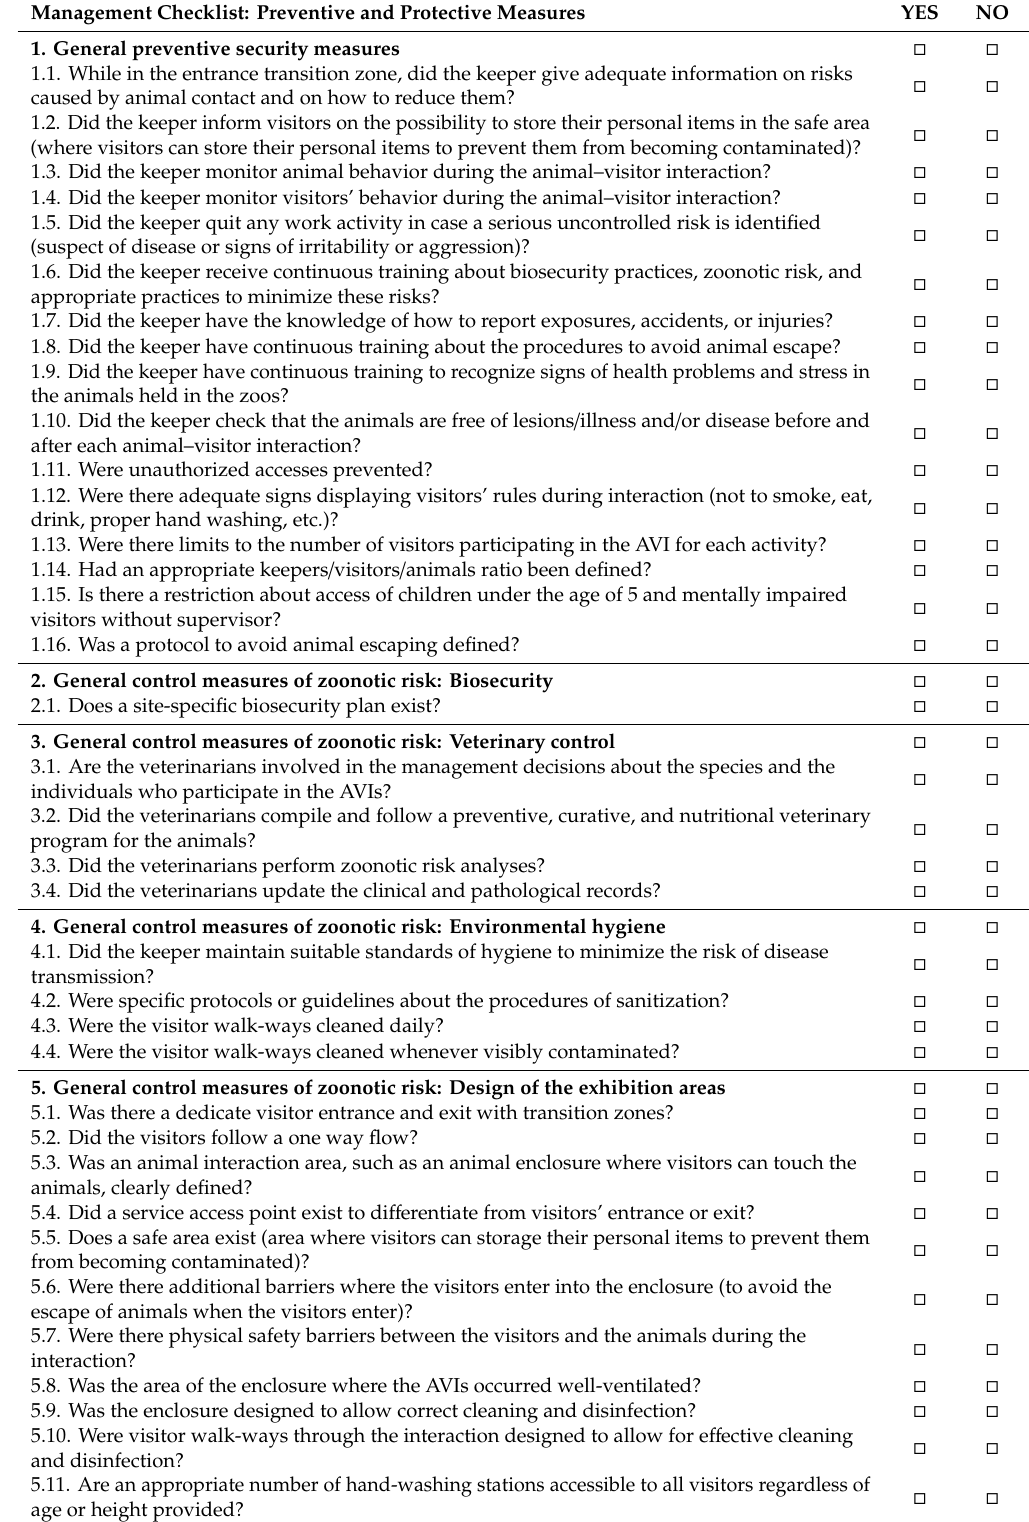
Table A2. Checklist for risk assessment related to visitors and keepers. Management Checklist: Preventive and Protective